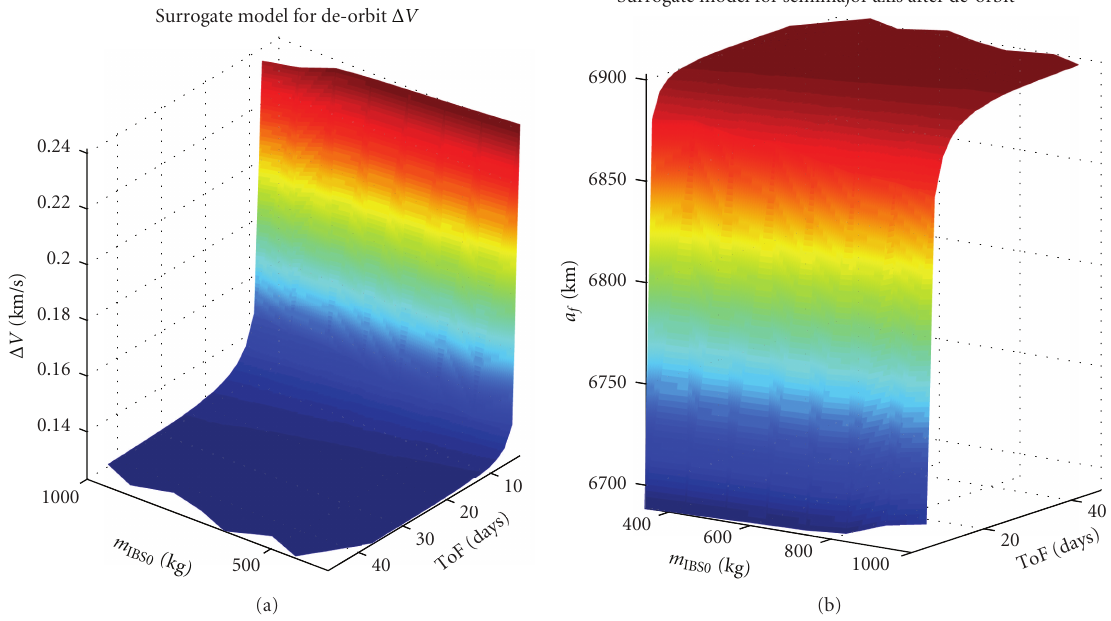
Figure 5: 3D Plot of surrogate models for a debr0 = 7128 km and m debr = 120 kg: (a) Δ V ; (b) a f